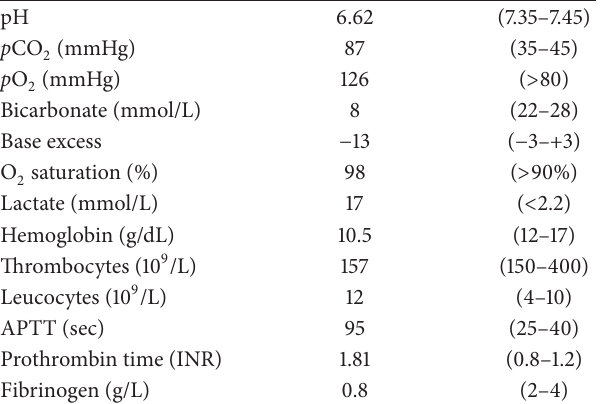
Table 1: Laboratory results on admission in